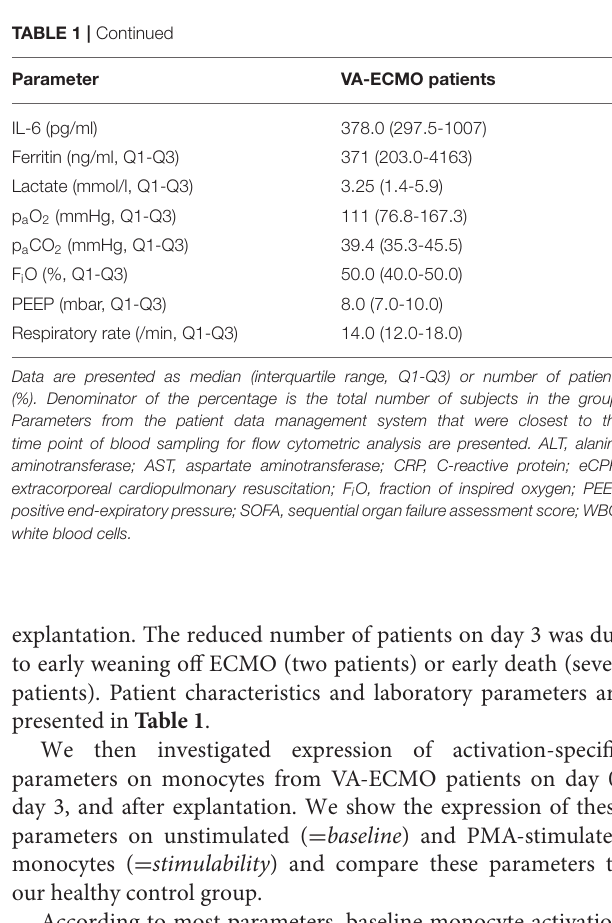
Figure 1C ). Monocyte stimulability on ECMO and even after explantation using these parameters was significantly reduced compared to healthy controls (e.g., percentage binding VA- ECMO day 0 vs. healthy controls F7: 43.1 ± 5.2 vs. 67.1 ± 3.3, p = 0.001, MAN-1: 33.1 ± 4.1 vs. 80.0 ± 2.0, p < 0.001, Figures 1B,D ).